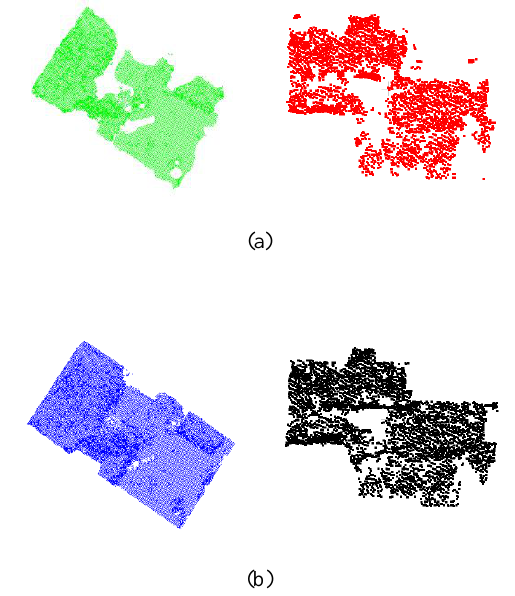
Figure 10: Building 2 segmentation of roof (left) and facade (right) (a) Proposed segmentation, (b) Manual segmentation